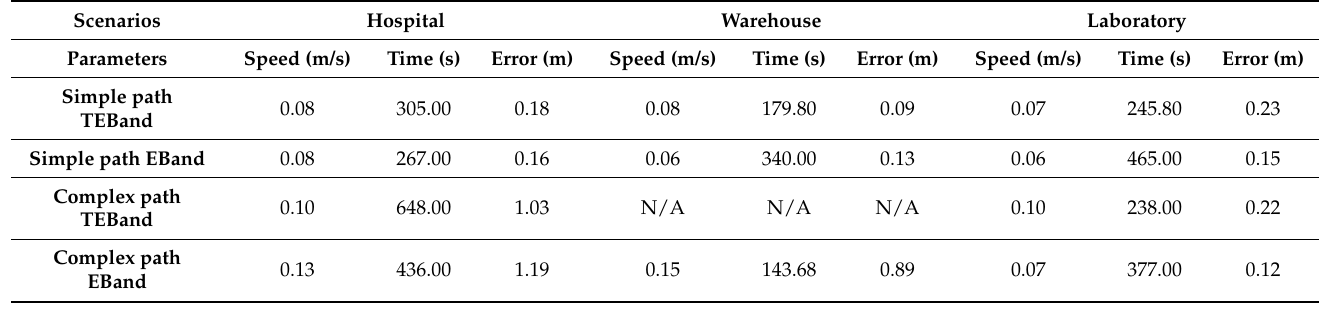
Table 3. Summary of simulation data obtained.